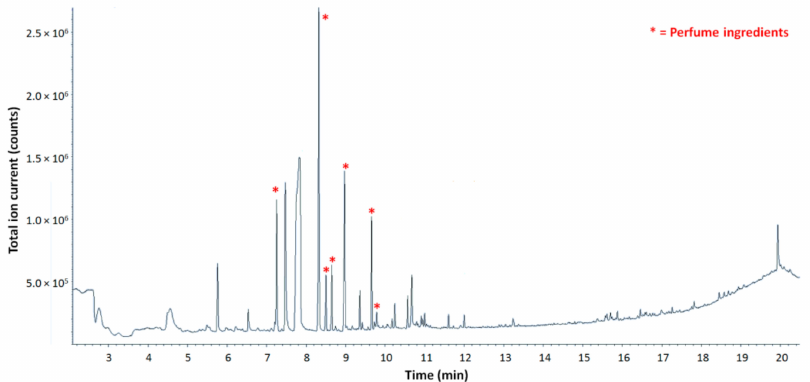
Figure 4. Typical pyrogram obtained for samples submitted to Py-GC-MS analysis (Sample 3). The chromatogram peaks corresponding to perfume ingredients are highlighted in red. The other peaks present correspond to pyrolysis products of the polymeric